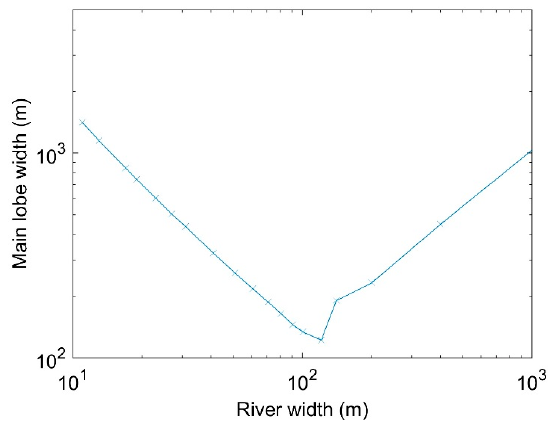
Figure 2. Main lobe width ( at 10 dB below peak) as a function of river width. Table 1. Relevant parameters characterizing the Envisat collection of Individual Echoes.